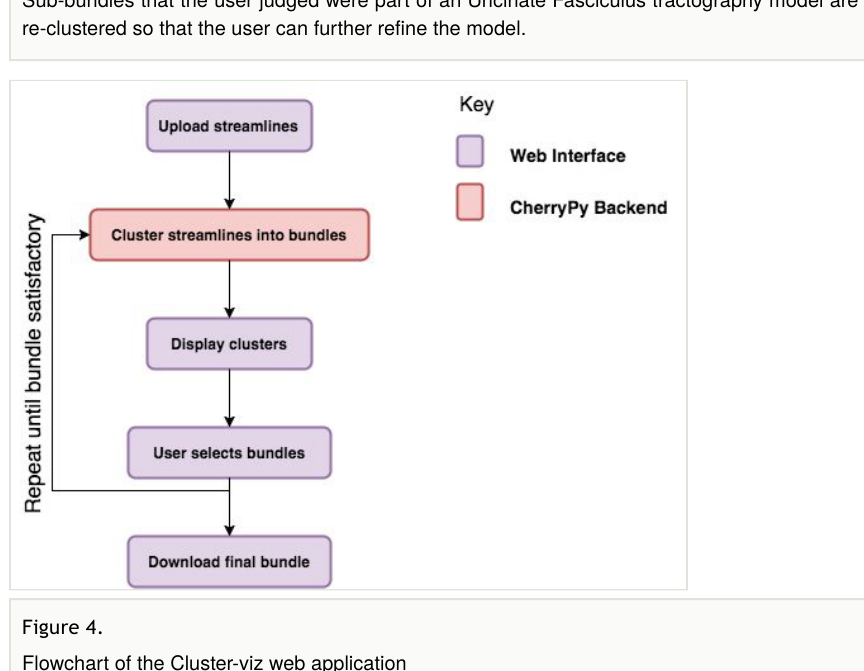
Flowchart of the Cluster-viz web